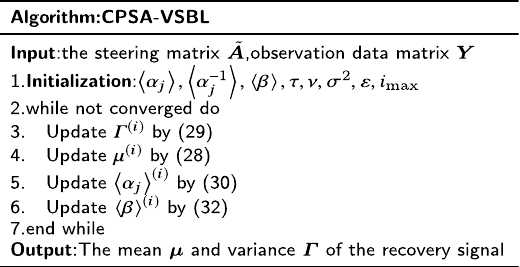
Table 1 The execution steps of CPSA-VSBL algorithm